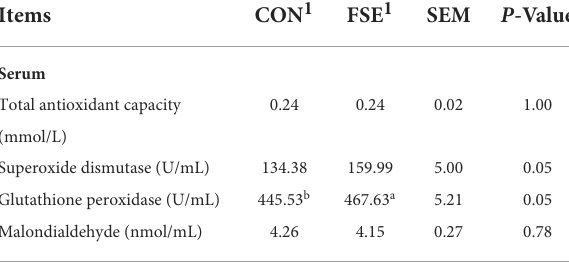
TABLE 6 Effect of Forsythia suspensa extract on the antioxidant status of finishing pigs.